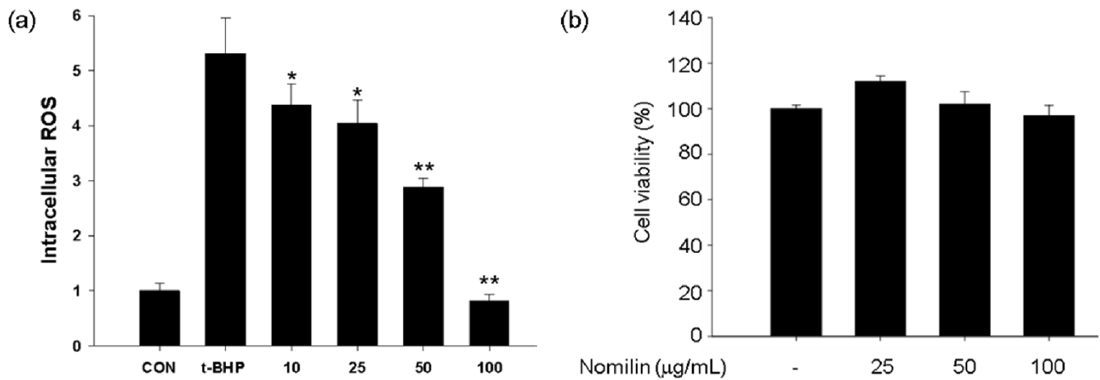
Figure 6. Measurement of ( a ) intracellular ROS production in and ( b ) viability of B16F10 melanoma cells treated with nomilin. Nomilin: 25–100 µg/mL (48.59–194.34 µM). * p < 0.05, ** p < 0.01, compared with t-BHP treatment.